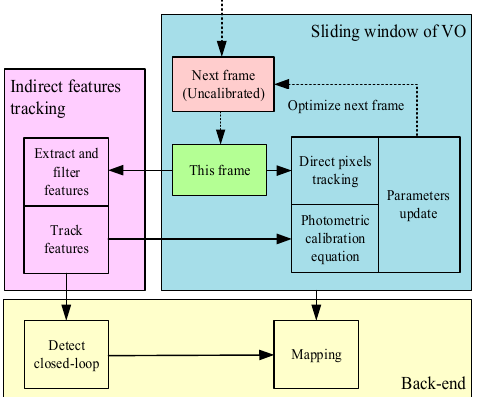
Figure 1. The flow chart of the proposed system. We divided the approach into three elements: The indirect feature tracker, the sliding windowed photometric compensation and the back-end optimization. The green one is the last frame that joins in the localization, mapping, and photometric parameters’ calculation. Then, the parameters were utilized to compensate the red frame based on the photometric parameters.